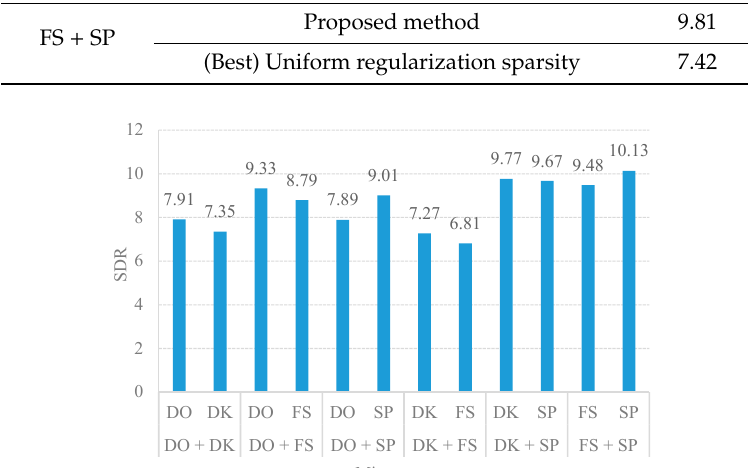
Figure 3. Average SDR results of six-mixture types.